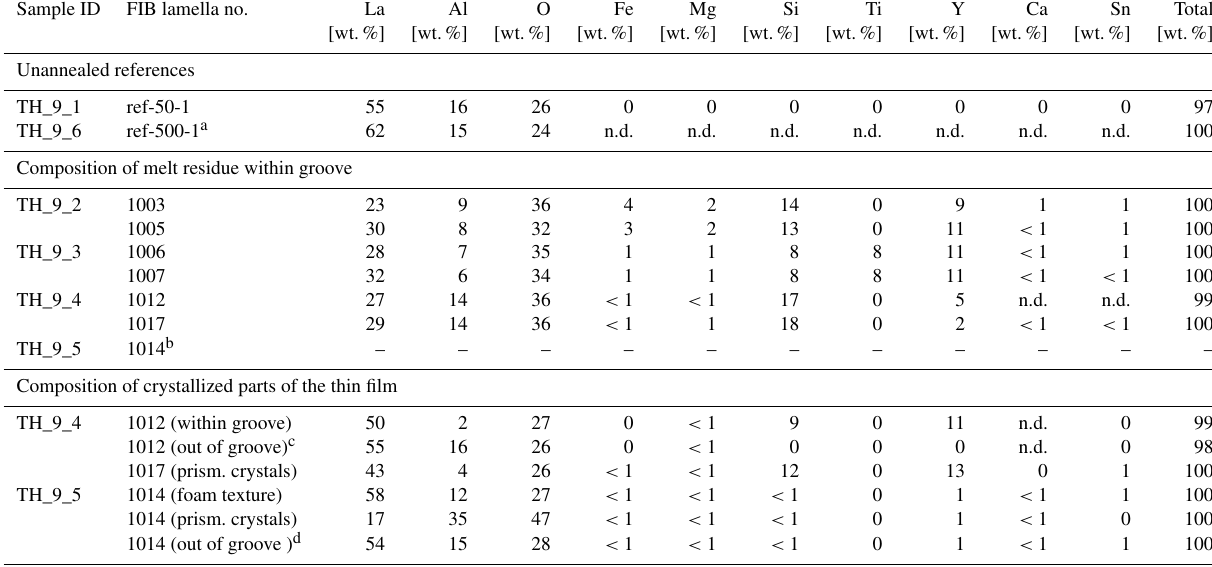
Composition of crystallized parts of the thin film